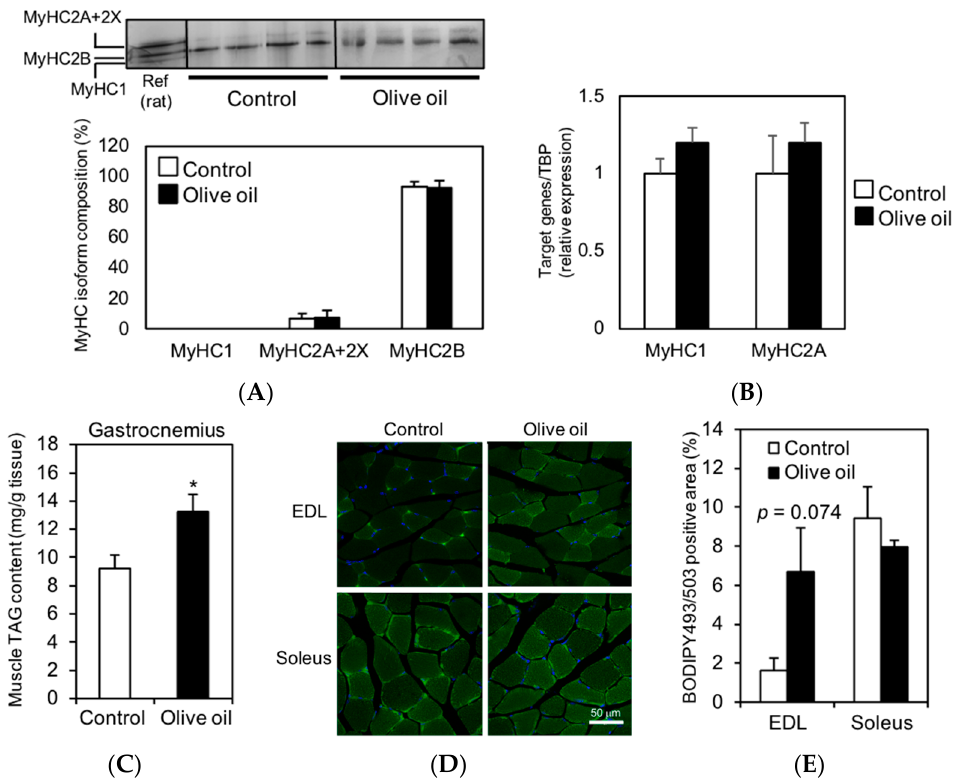
Figure 2. Muscle fiber type compositions and IMTG accumulation in skeletal muscles. ( A ) Separation of myosin heavy chain (MyHC) isoforms by SDS-PAGE analysis. A mixed sample of rat soleus and EDL muscle was used as the three MyHC isoform references (the migration rate was MyHC1 > 2B > 2A+2X). The graph shows the composition of MyHC isoforms in control and olive oil-fed mice. ( B ) Relative expression levels of MyHC1, 2A normalized to TBP expression. ( C ) Whole TAG content in gastrocnemius muscle (mg/g tissue). Results are presented as means ± SE ( n = 8), *, p < 0.05 vs. control group. ( D ) Representative images of muscle specimens stained with BODIPY493/503 in mouse EDL (left panels) or soleus (right panels) muscle. ( E ) Results were calculated BODIPY493/503 positive area/total area. Results presented as means ± SE ( n = 4).